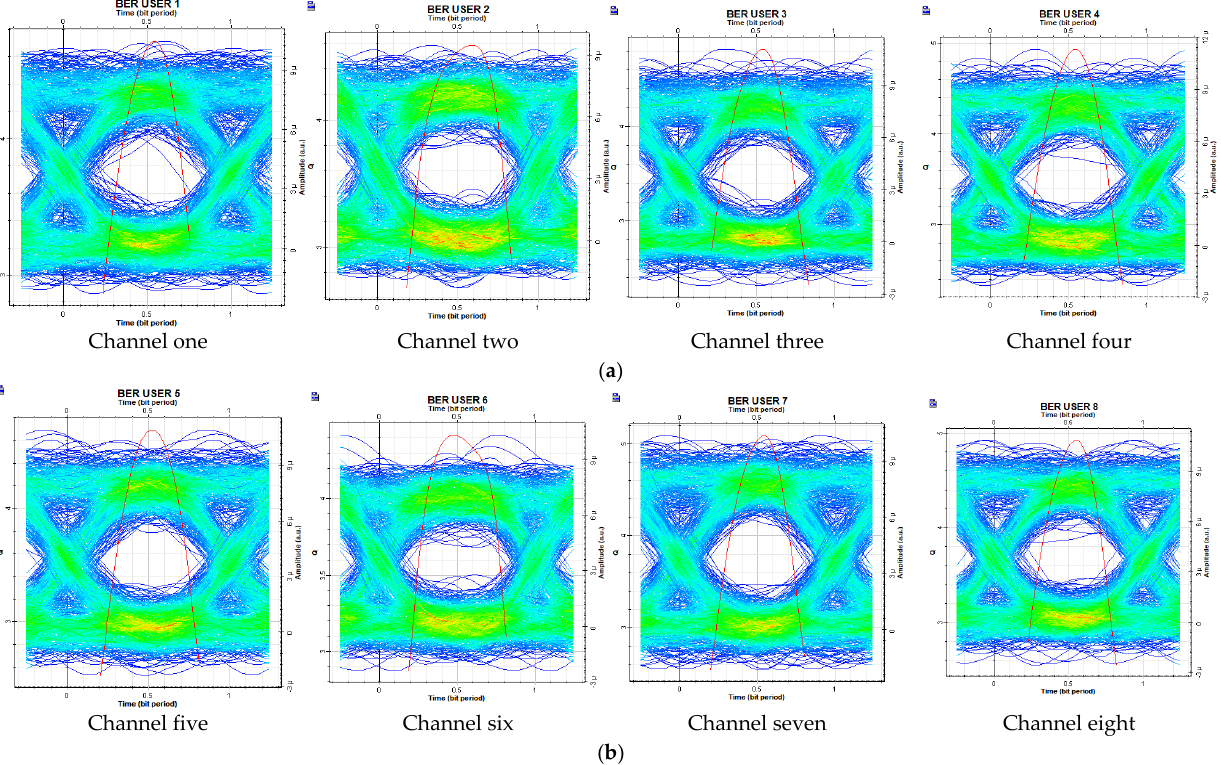
Figure 4. Eye diagrams for eight channels of the FSO-PDM/PV-OCDMA system transmitted on ( a ) x-polarization and ( b ) y-polarization.